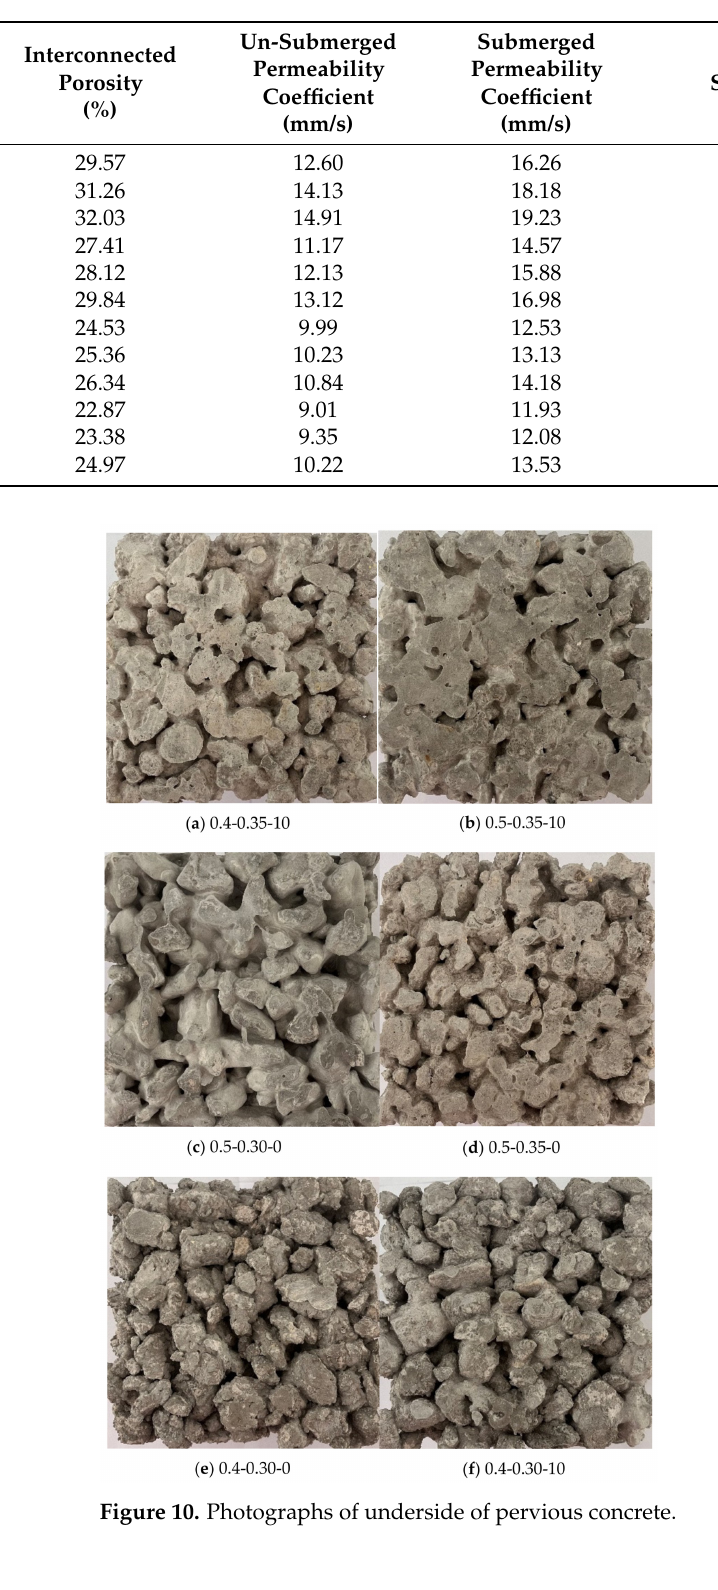
Table 3. Test results of pervious concretes.